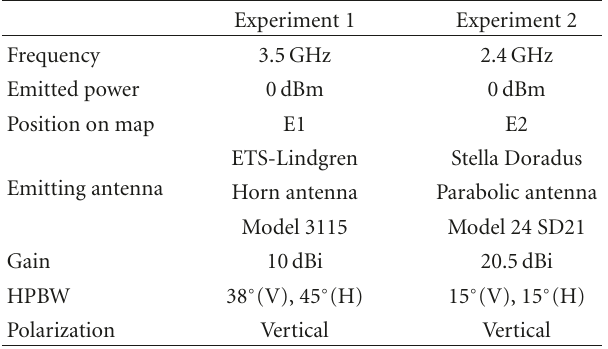
Table 3: Accuracy of the model: RMSE/ME in